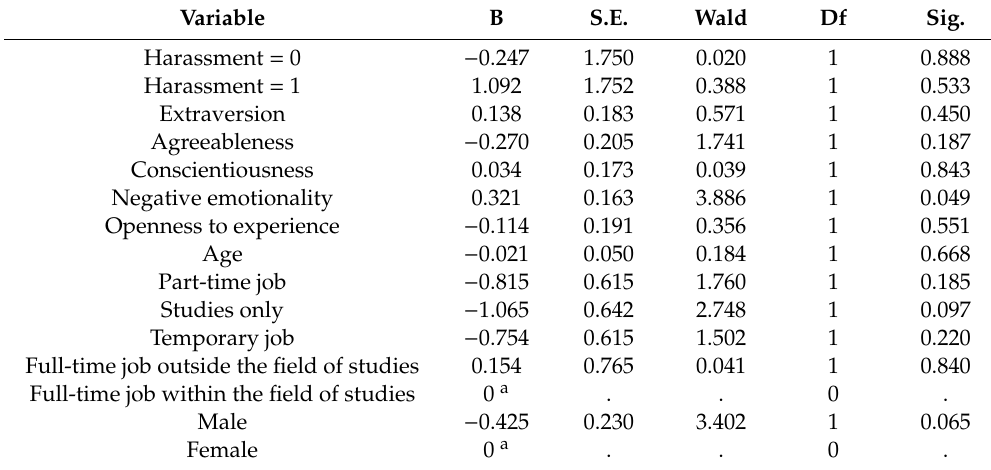
Table 9. Full Model 9—Harassment: ordinal logistic regression.